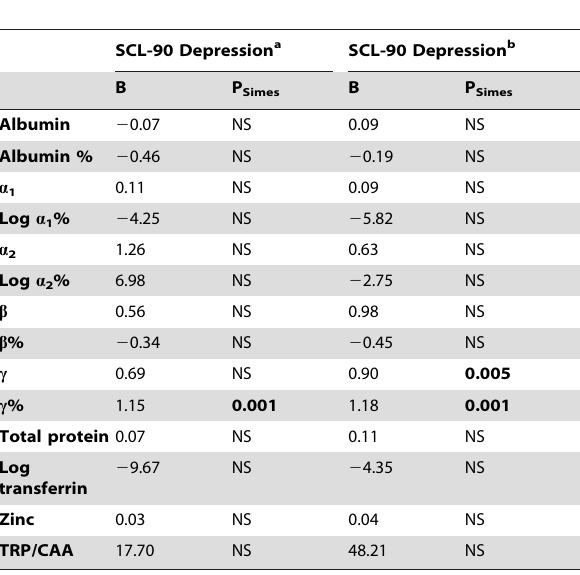
Table 6. Association between SCL-90 depression scores and immune parameters and TRP/CAA over